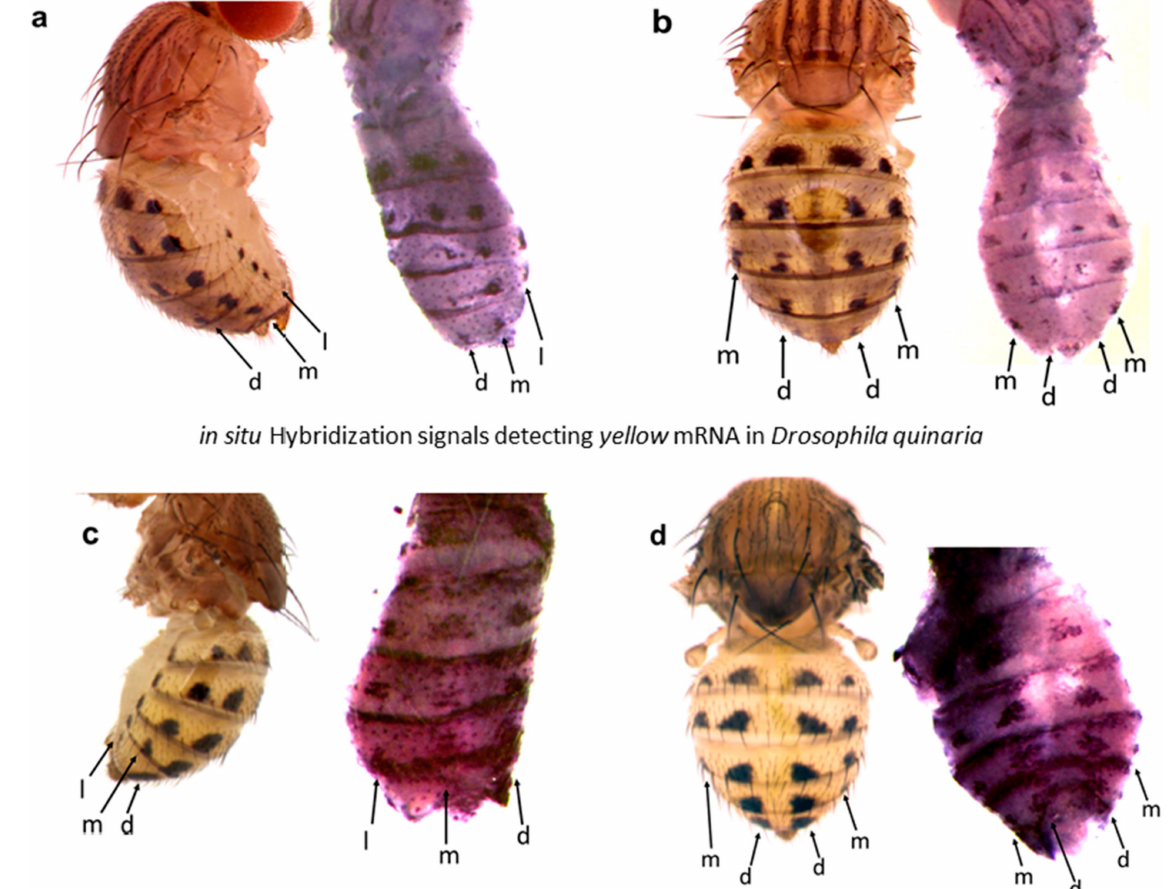
Figure 6. in situ Hybridization signals detecting yellow mRNA during pupal stage P10 of D. guttifera and D. quinaria foreshadow the abdominal spot patterns of the adults. ( a , c ) Dorsal cuts showing the lateral pattern of yellow mRNA expression in D. guttifera and D. quinaria , respectively. ( b , d ) Lateral cuts showing the dorsal pattern of yellow mRNA expression in D. guttifera and D. quinaria , respectively. The spot rows are designated as lateral (l), median (m), and dorsal